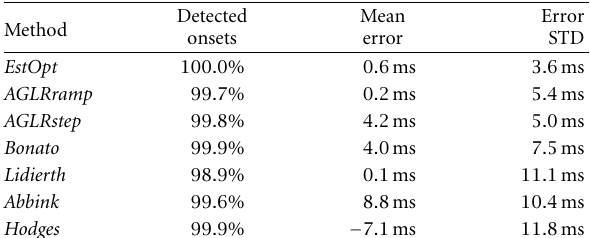
Table 2: Statistics for onset estimates based on SEMG data set “Mixed